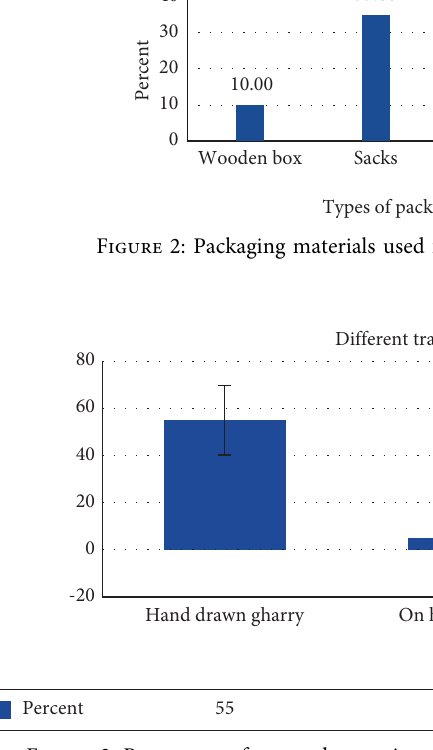
Figure 3: Percentage of respondents using different transportation methods n �